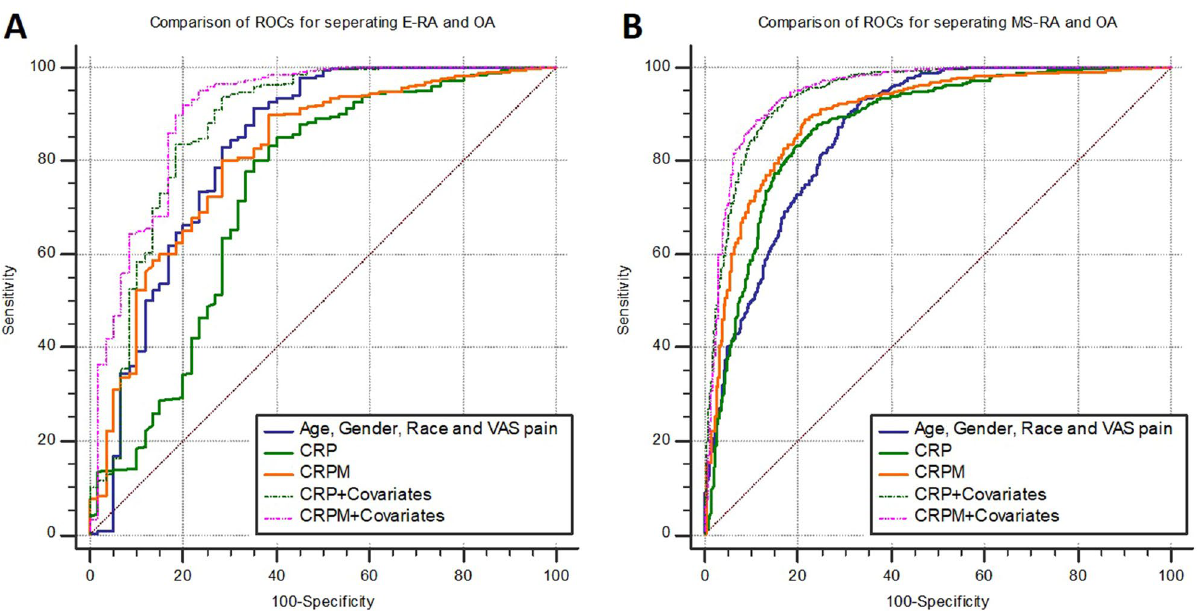
Figure 2. ROC analyses of for separating OA from either E-RA or MS-RA including covariates (Age, gender, race, BMI* and VAS pain) or markers alone or in combination. *BMI was only available for the MS-RA and OA